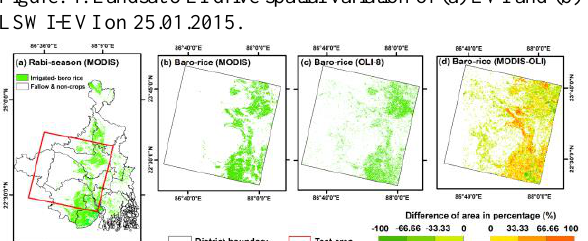
Figure. 4. Landsat OLI drive spatial variation of (a) EVI and (b)